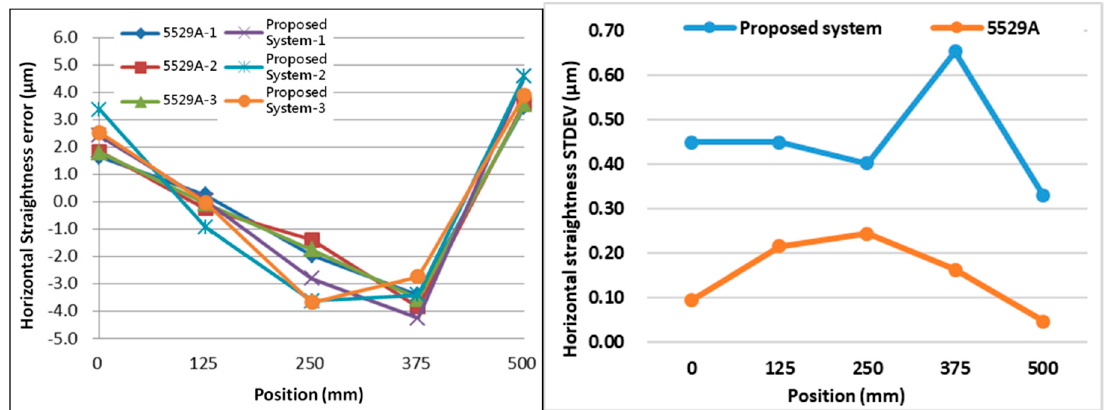
Figure 14. Results of horizontal straightness measurement.